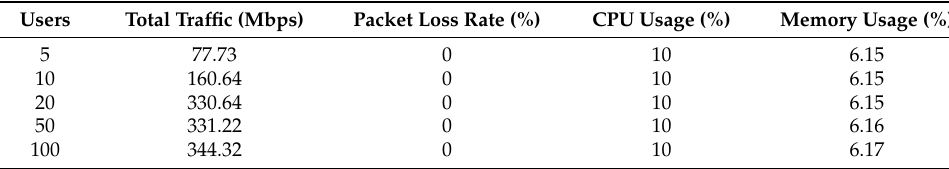
Figure 13. Load Test 20, 50, & 100 Users Latency Result. Table 5. Load test MEC management system